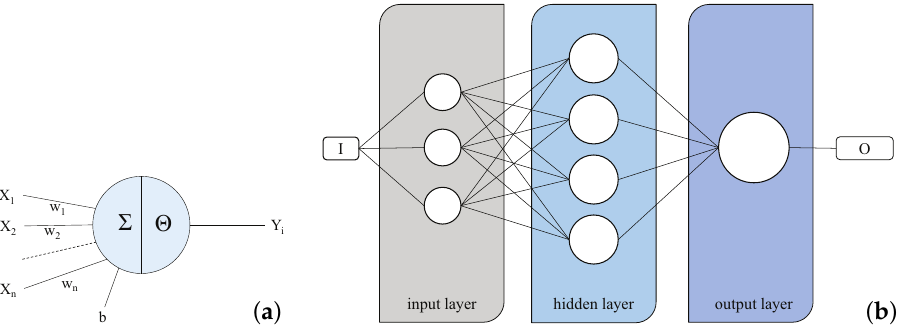
Figure 1. ( a ) Scheme of an artificial neuron; and ( b ) Scheme of a Feed-forward network.